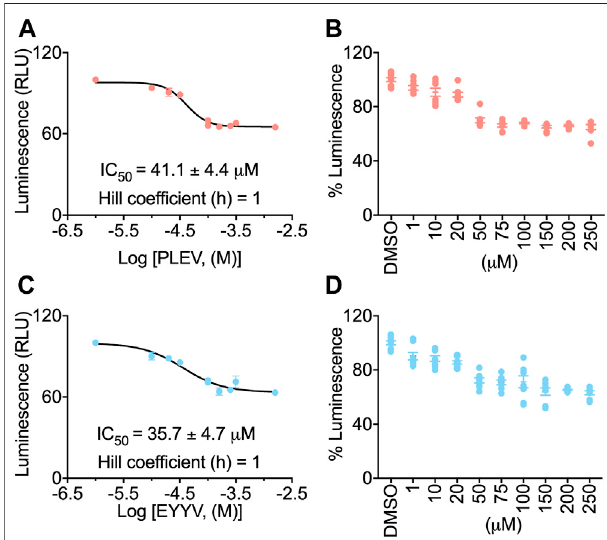
FIGURE2| In-cellevaluationofdose-dependenteffectsofthePLEVand EYYV tetrapeptides on FGF14:Nav1.6 complex assembly using the LCA. (A) Percent luminescence plotted as a function of log concentration of PLEV to characterize the dose-dependent effects of the tetrapeptide on FGF14: Nav1.6 complex assembly. (B) Bar graph showing dose-response as depicted in panel A. (C) Percent luminescence plotted as a function of log concentration of EYYV to characterize the dose-dependent effects of the tetrapeptide on FGF14:Nav1.6 complex assembly. (D) Bar graph showing dose-response as depicted in panel B. PLEV or EYYV concentrations were used (1, 10, 25, 50, 75, 100, 150, and 250 μ M; n (cid:2) 8 per concentration) for dose response. Data were normalized to per plate wells treated with 0.5% DMSO, and non-linear regression curve was performed using GraphPad Prism to calculate IC Data represented as mean ±